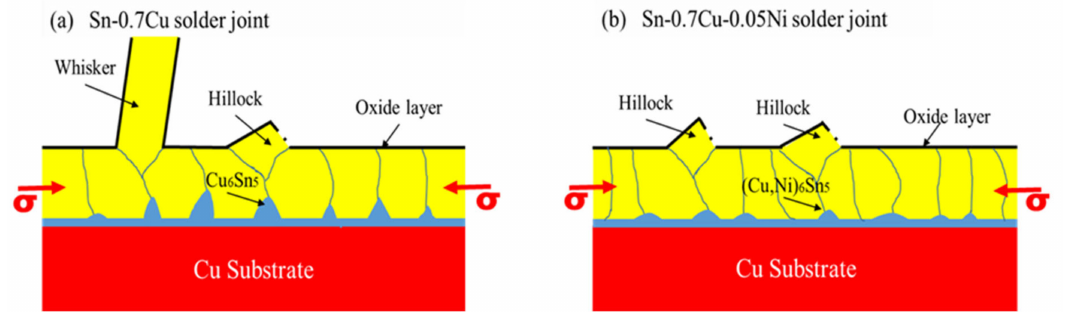
Figure 10. A schematic diagram illustrating the correlation between IMC interfacial growth and Sn whisker growth on ( a ) Sn-0.7Cu and ( b ) Sn-0.7Cu-0.05Ni.